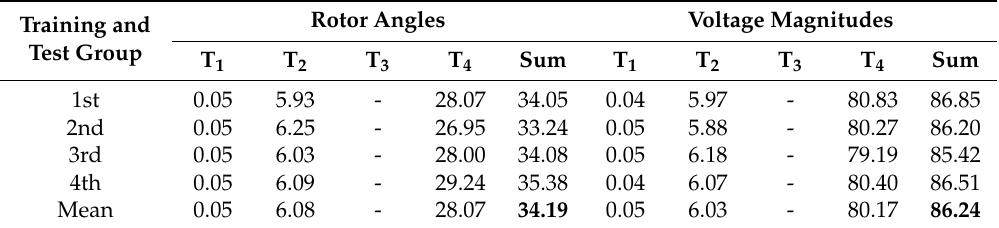
Table 3. Processing time for the total dataset.